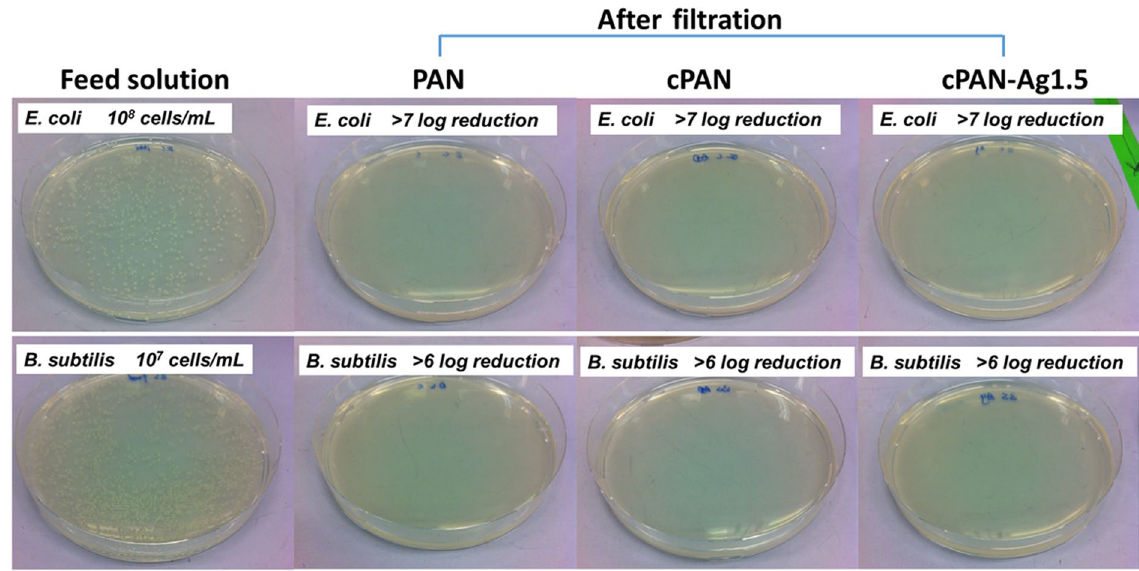
Figure 5. Photographs of colonies formed by B. subtilis and E. coli in water samples before and after filtration through PAN, cPAN, and cPAN-Ag1.5 nanofibrous membranes.